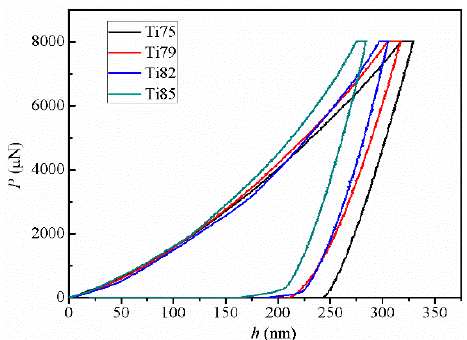
Figure 8. Representative load ( P )-displacement ( h ) nanoindentation curves for the Ti-Nb-Sn alloys. The Ti 85 Nb 10 Sn 5 , Ti 82 Nb 13 Sn 5 , Ti 79 Nb 16 Sn 5 , and Ti 75 Nb 20 Sn 5 alloys are labeled by Ti85, Ti82, Ti79 and Ti75, respectively.